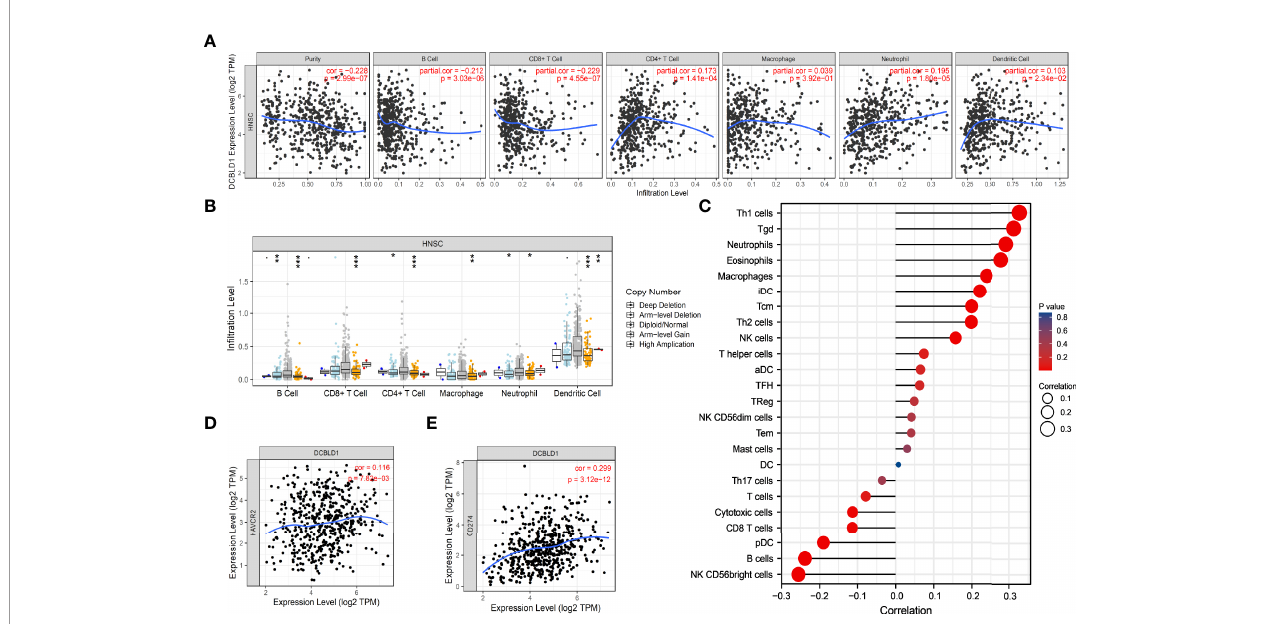
FIGURE 7 | The immune in fi ltration of DCBLD1 expression in HNSCC. (A) Association between DCBLD1 expression and the in fi ltration of immune cells. (B) The visualization between DCBLD1 expression and SCNA in HNSCC from the TCGA data. (C) Correlations between 24 immune cells and DCBLD1 expression. (D) The correlation of DCBLD1 and HAVCR2 (TIM-3). (E) The correlation of DCBLD1 and